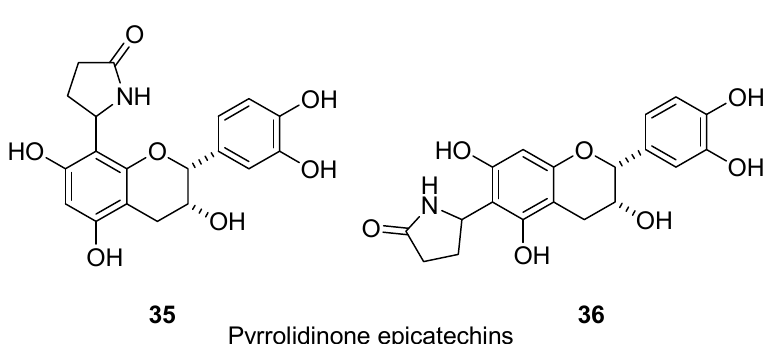
Figure 12. Pyrrolidinone epicatechins ( 35 and 36 ).